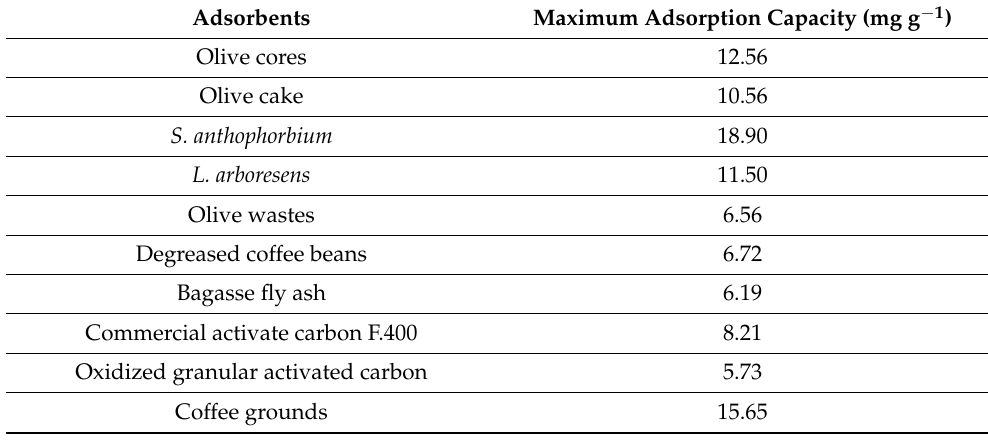
Table 8. Comparison of adsorption capacity of different adsorbents with spent coffee grounds. Own compilation based on literature data [109].